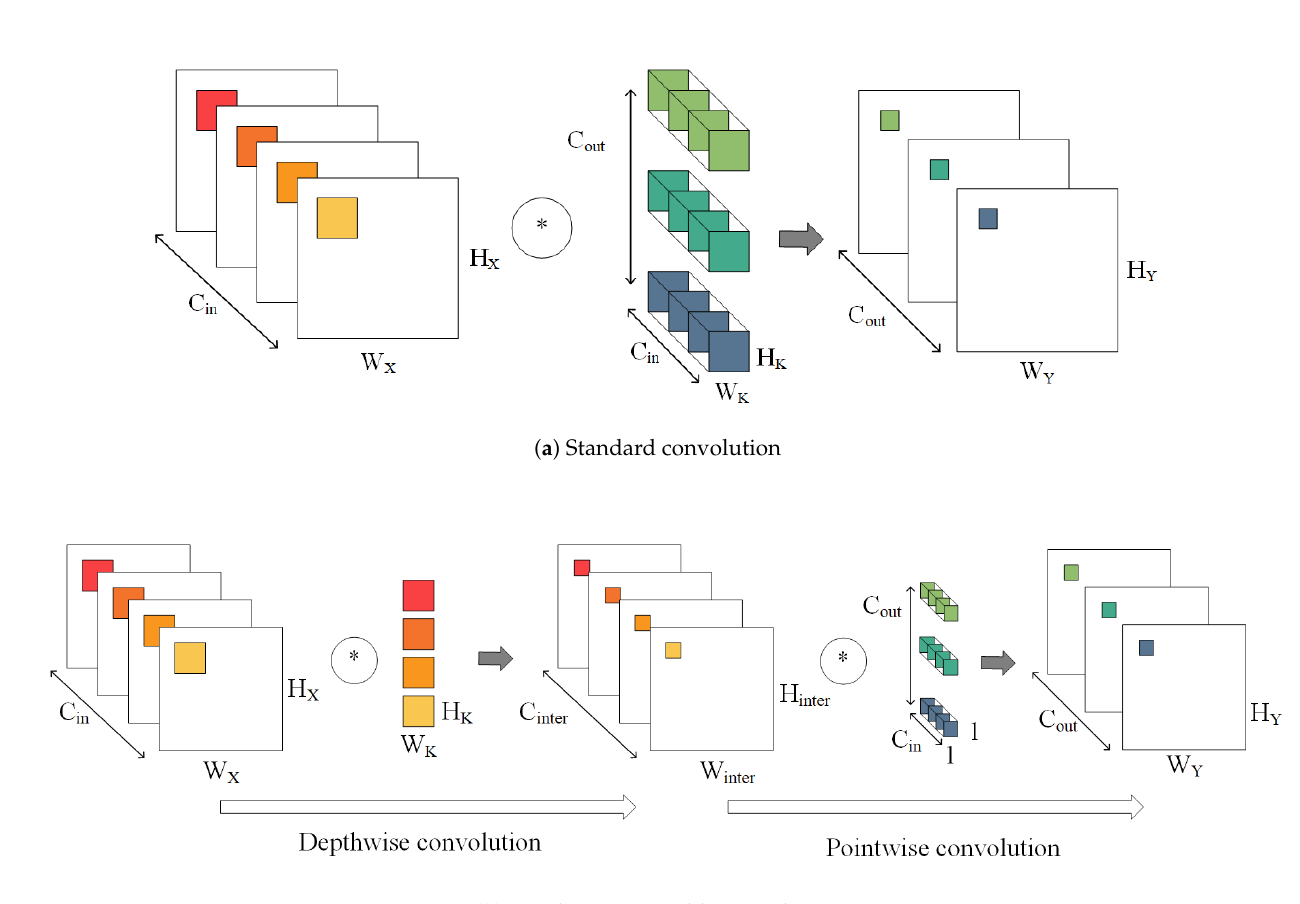
Figure 1. The working principle of standard convolution and depthwise seperable convolution. In depthwise convolution, each convolution kernels is convoluted with each input channels. In pointwise convolution, convolution kernel is a 1 × 1 standard